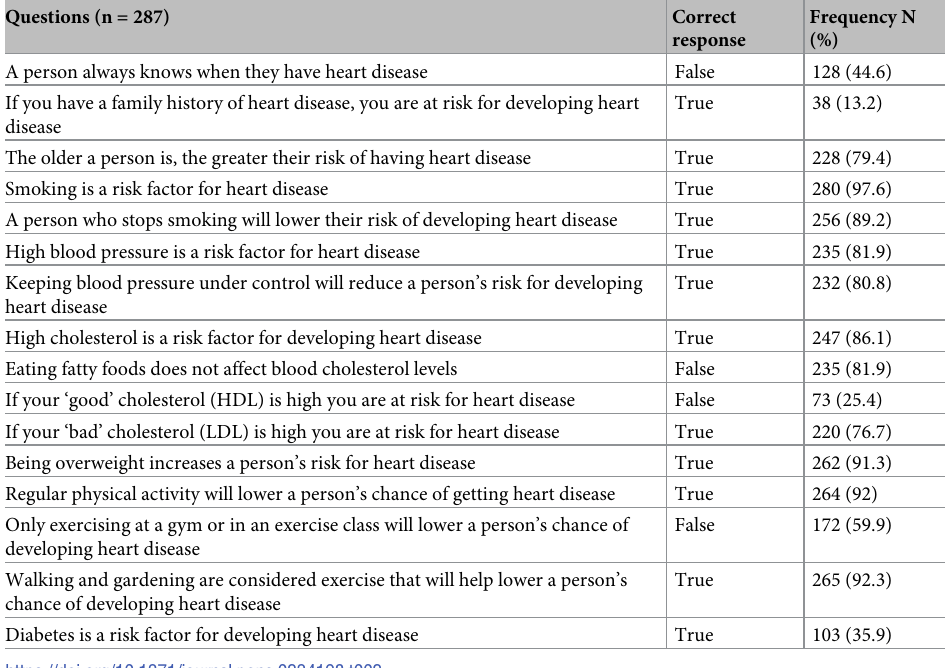
Table 2. Responses to the HDFQ among patients attending chronic follow up care in eastern Ethiopia, 2018. Questions (n =